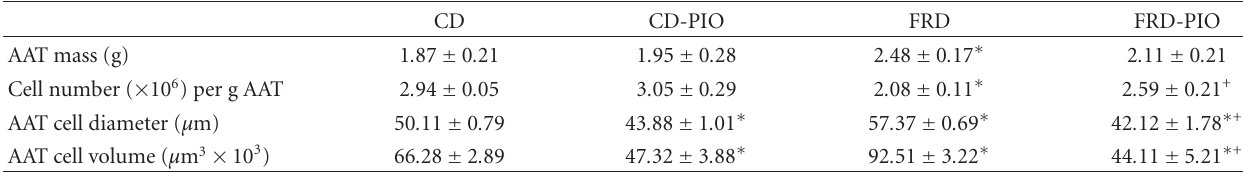
Table 3: Abdominal adipose tissue (AAT) characteristics in male rats fed either a CD or FRD combined or not with PIO treatment.